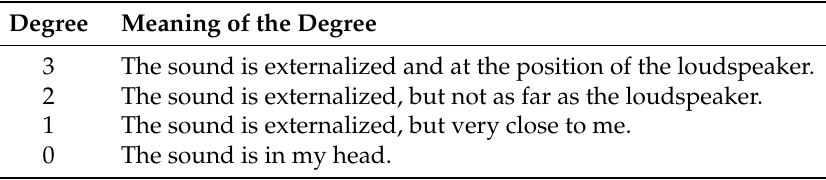
Figure 7. A photograph of the experimental setup. Seven loudspeakers were positioned at − 90°, − 60°, − 30°, 0°, 30°, 60°, and 90° relative to the subject with a distance of 1.9m. The subject evaluated the externalization ratings of test stimuli via a graphical user interface (GUI) implemented on the Max/MSP platform [31] on a Thinkpad laptop. The Fireface UFX+ audio interface can be seen on the left side of the laptop. Table 1. A subjective rating scale to rate the degree of perceived